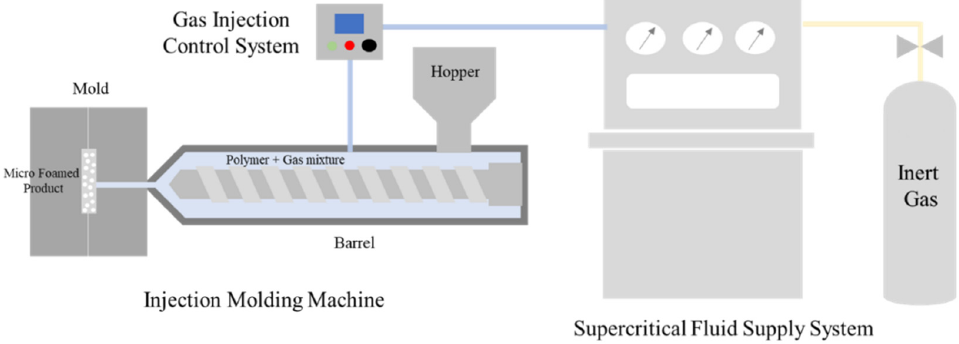
Figure 1. Microcellular-foaming-process applied injection molding process.